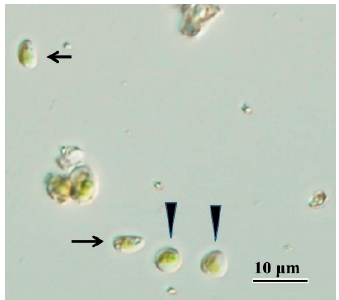
Figure 6. The morphology of algal cells in ZT, Province YNP.